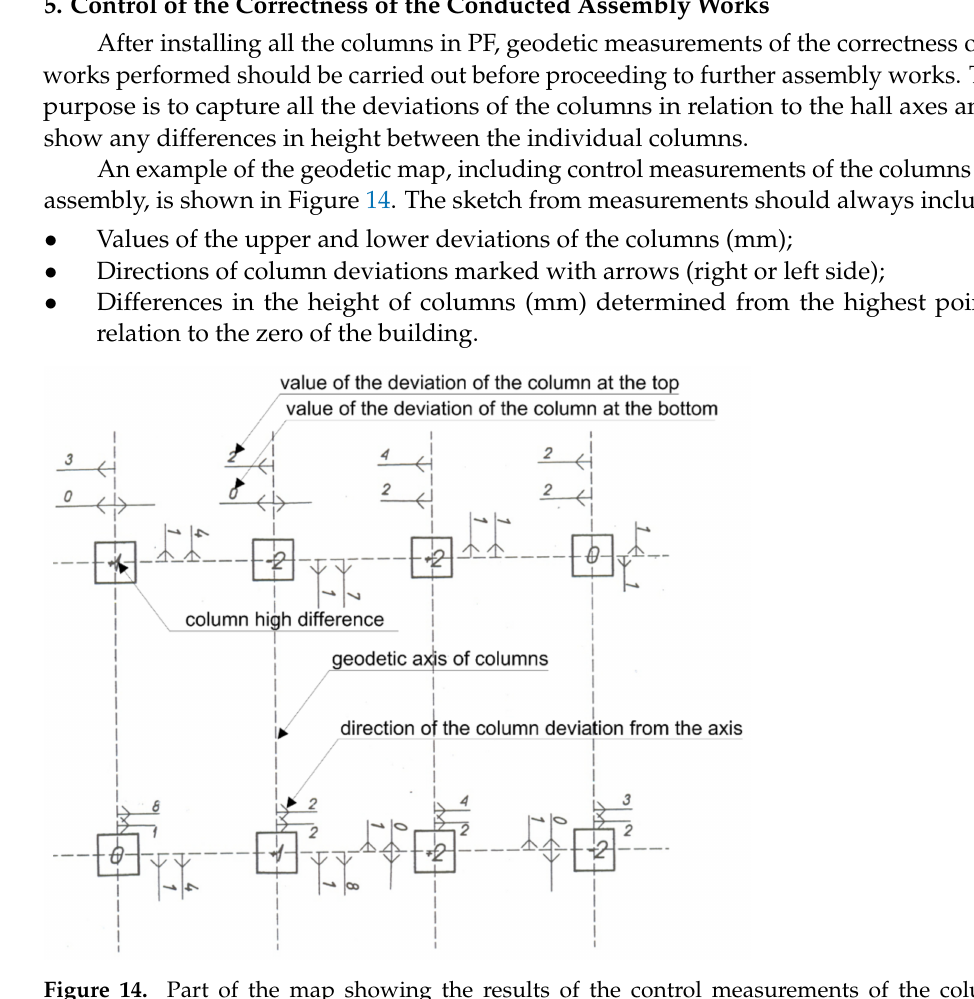
Figure 14. Part of the map showing the results of the control measurements of the columns after